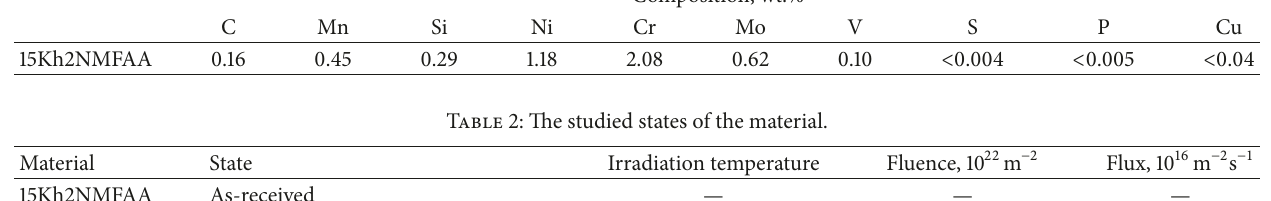
Table 1: The chemical composition of 15Kh2NMFAA steel. Composition, wt.%